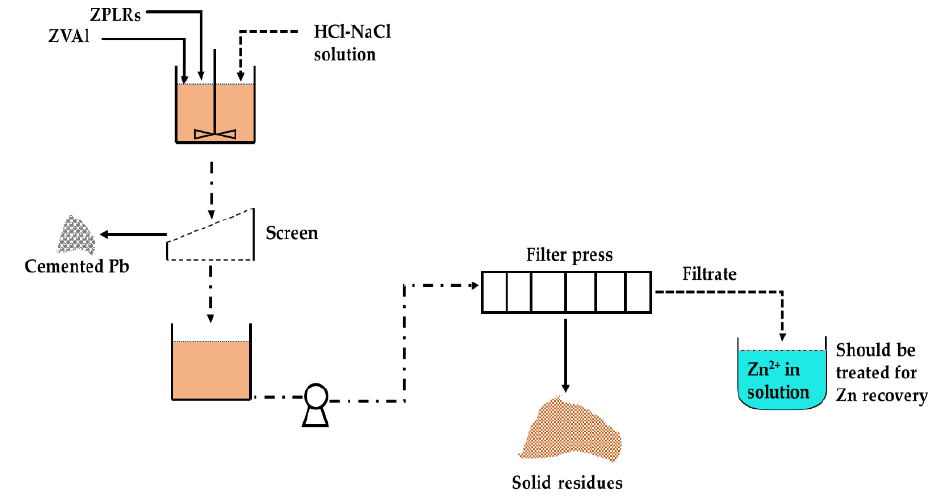
Figure 13. A conceptual flowsheet of the treatment of ZPLRs using the concurrent dissolution- cementation technique.